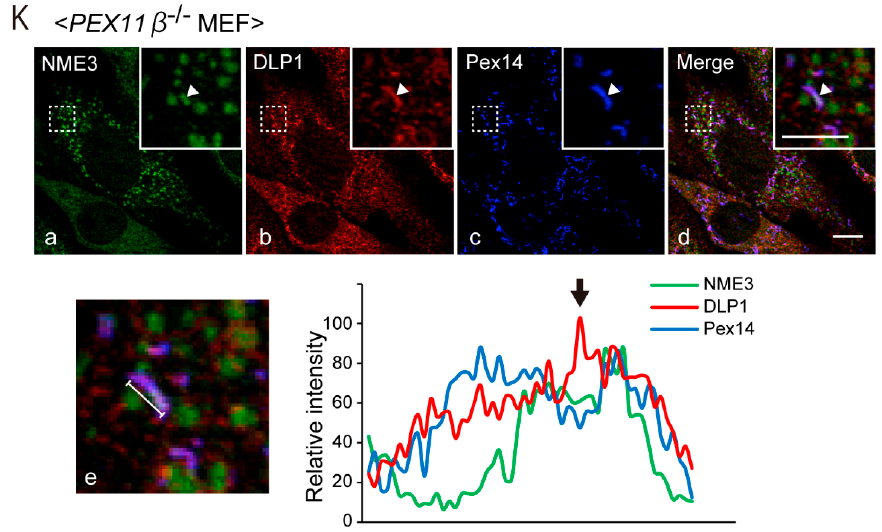
Figure 7. NME3 is localized to peroxisomes and involved in the fission of peroxisomes. ( A ) intracellular localization of endogenous NME3 in HeLa cells was assessed by indirect immunofluorescent cell staining with antibodies to DYNAMO1 (green), Pex14, and Tom20 as in Figure 6. Scale bar, 10 µm. Higher magnification images of the boxed regions are shown (Inset). Scale bar, 5 µm. Note that mitochondrial localization of NME3 is distinct (lower panels). ( B ) HeLa cells transfected with dsRNA against NME3 (#28, see Figure 3) were verified by indirect immunofluorescent cell staining with anti-bodies to DYNAMO1 and Tom20. Scale bar, 10 µm. ( C ) HeLa cells transfected with dsRNA against ATAD1 were verified by indirect immunofluorescent cell staining as in ( A ). Scale bar, 10 µm. Higher magnification images of the boxed regions are shown (Inset). Scale bar, 5 µm. Note that localization of NME3 in peroxisomes (arrowheads), but not mitochondria, is more readily discernible. ( D ) HeLa cells co-transfected with a set of two dsRNAs against ATAD1 and NME3 were verified by indirect immuno- fluorescent cell staining with antibodies to DYNAMO1 and Pex14. Higher magnification images of the boxed regions are shown (Inset). Note that peroxisomes are frequently elongated. Scale bar, 10 µm. Higher magnification images of the boxed regions were shown (Inset). Scale bar, 5 µm. ( E ) relative fluorescent intensity of NME3 in HeLa cells transfected with mock (-, n = 38) or dsRNA against ATAD1 (+, n = 25) was quantified. * p < 0.05. ( F , G ) transcription level of ATAD1 ( F ) and NME3 ( G ) in HeLa cells treated as in ( C ) was quantified by quantitative real-time PCR (n = 3). ( H ) protein level of Pex14 was verified by immunoblotting (left). β -actin, a loading control. Protein level of Pex14 was represented as values relative to that in mock-treated HeLa cells (right, n = 3). ( I ) the number of peroxisomes in HeLa cells untreated (n = 37), transfected with dsRNA against ATAD1 alone (n = 37), or a set of ATAD1 and NME3 (n = 33) was represented. *** p < 0.001, by Tukey-Kramer test. n.s., not significant. ( J ) NME3 level is elevated by ATAD1 knockdown. siControl and siATAD1 were separately transfected twice with a 24 h interval to HeLa cells that had been transfected for 6 h with a plasmid encoding NME3. After 24-h cell culture, transcription level of ATAD1 (left) was quantified by quantitative real-time PCR (n = 2). Center , NME3 expression levels were assessed by western blotting of respective cell lysates with anti-NME3C antibody. Two bands, NME3-1 and NME3-2, marked by solid and open arrowheads were detected. β - actin, a loading control. Dots indicate non-specific bands; right, NME3-1 and NME3-2 bands were quantified and represented by taking as 1 NME3-1 in siControl -transfected cells in lane 1. ( K ) upper row, NME3 was expressed in PEX11 β − / − mouse embryonic fibroblasts (MEF) [12] and its intracellular localization was verified by staining with antibodies to DYNAMO1 ( a ), DLP1 ( b ), and Pex14 ( c ). Scale bar, 10 µm. Higher magnification images of the boxed regions were shown (Inset). Scale bar, 5 µm. Note that NME3 was detected in the limited area of an elongated peroxisome (arrowhead). Panel ( e ), signal intensity of NME3, DLP1, and Pex14 in the elongated peroxisome indicated with its length in the merged view was analyzed by line scanning and represented. Note that NME3 was localized at the DLP1- accumulated potential constriction site (arrowhead in ( a – d )) where signal of Pex14 is weak and the both sides adjacent to this region the constriction site.